Question: Identify the chart type used in this figure.
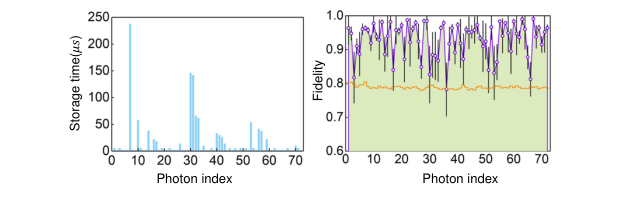
Answer: bar